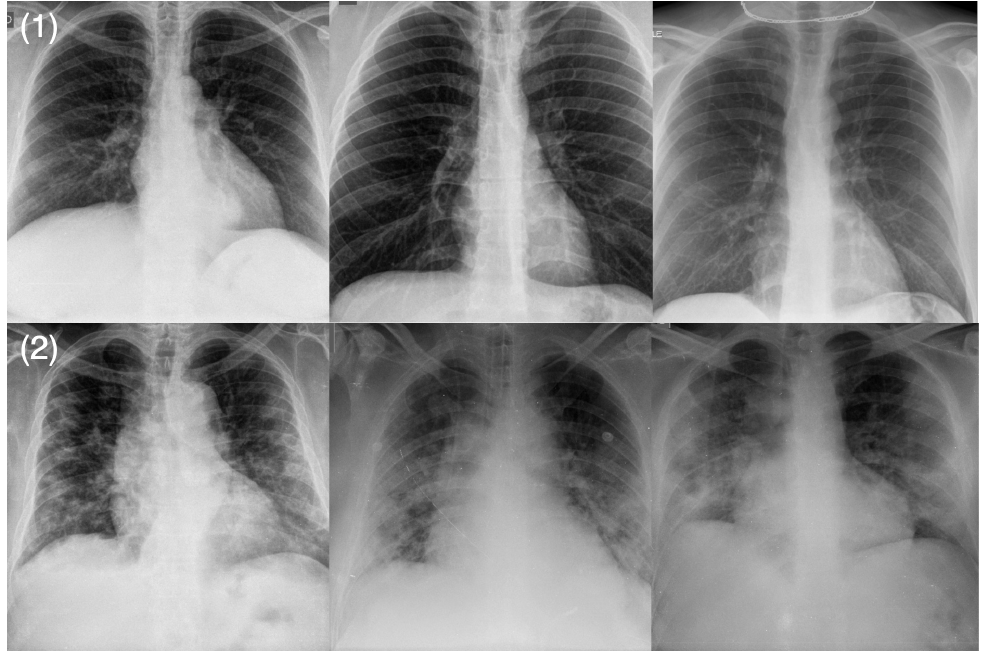
Figure 2. Example chest X-ray images from the RSNA RICORD dataset: ( 1 ) Level 1 airspace severity: opacities in 1–2 lung zones and ( 2 ) Level 2 airspace severity: opacities in 3 or more lung